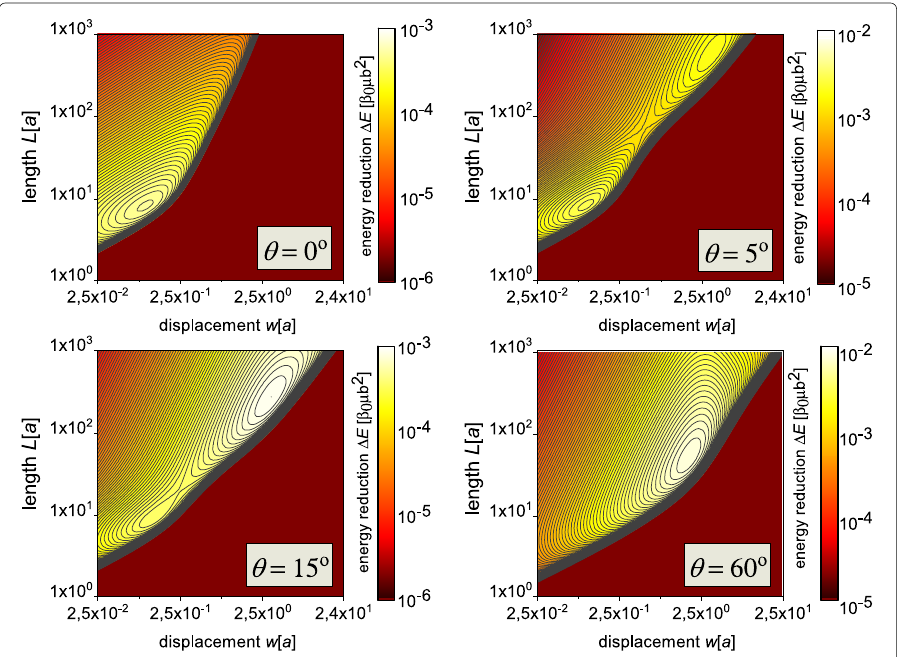
Fig. 2 Energy landscapes for dislocations of various orientation, energy reduction of segments of length L displacing over the distance w according to Eq. (19), angles are given in the figures